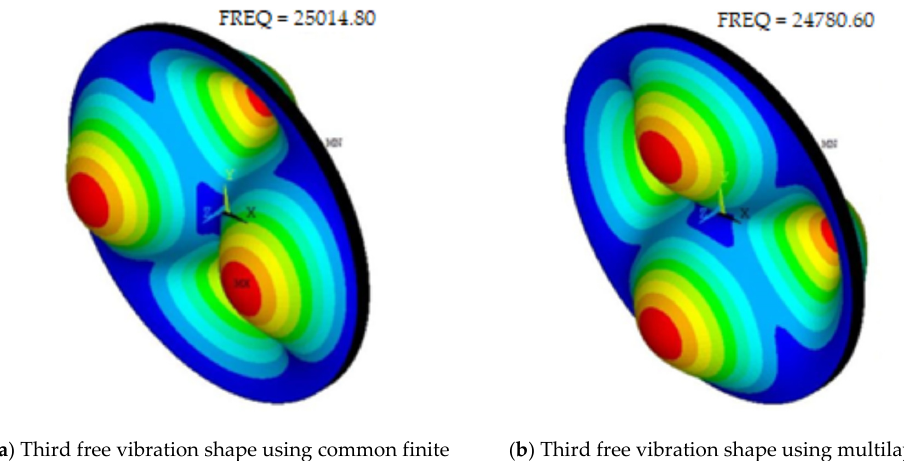
Figure 25. The shape of the second frequency ( n = 1; s = 0), Model_I ( a ) and Model_II ( b ).